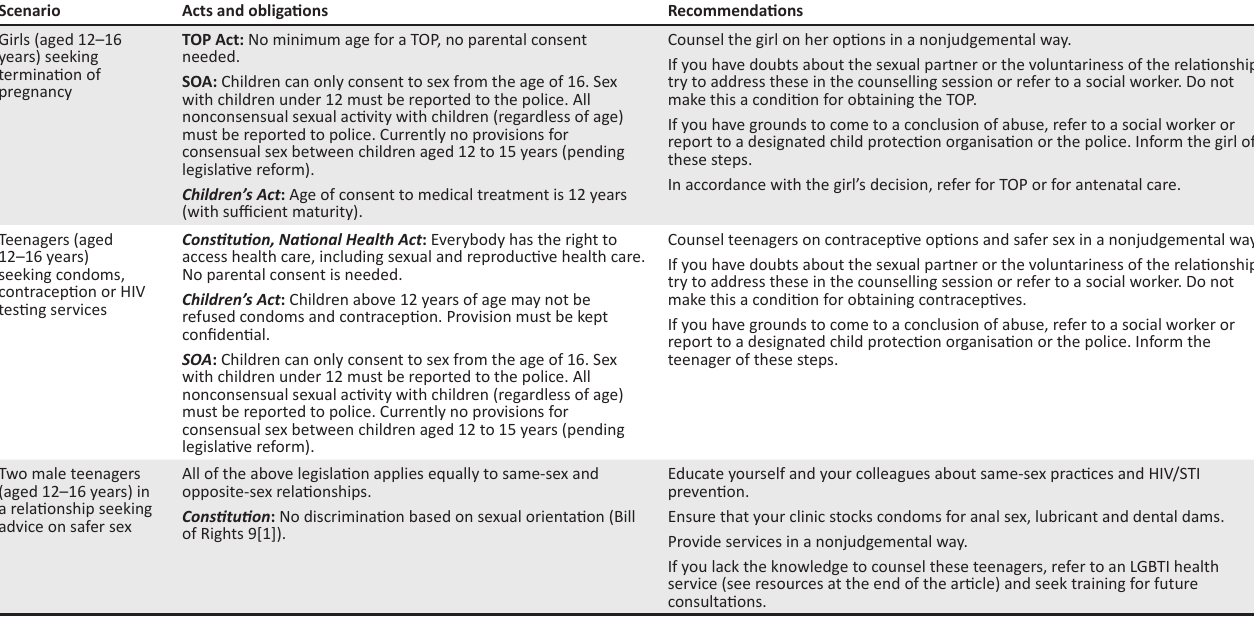
TABLE 4: Strategies for navigating conflicting laws. Scenario Acts and obligations